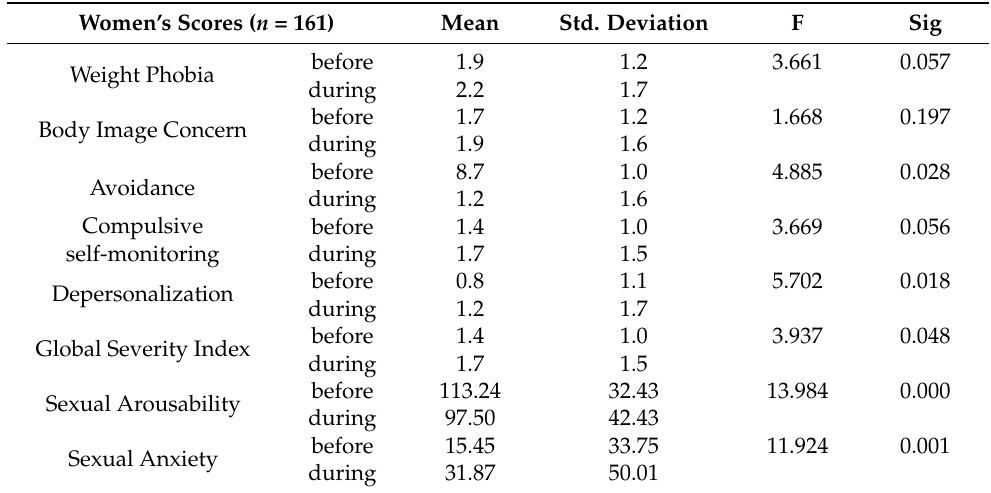
Table 2. Comparison of body variables and sexual arousal and anxiety before and during the lockdown in